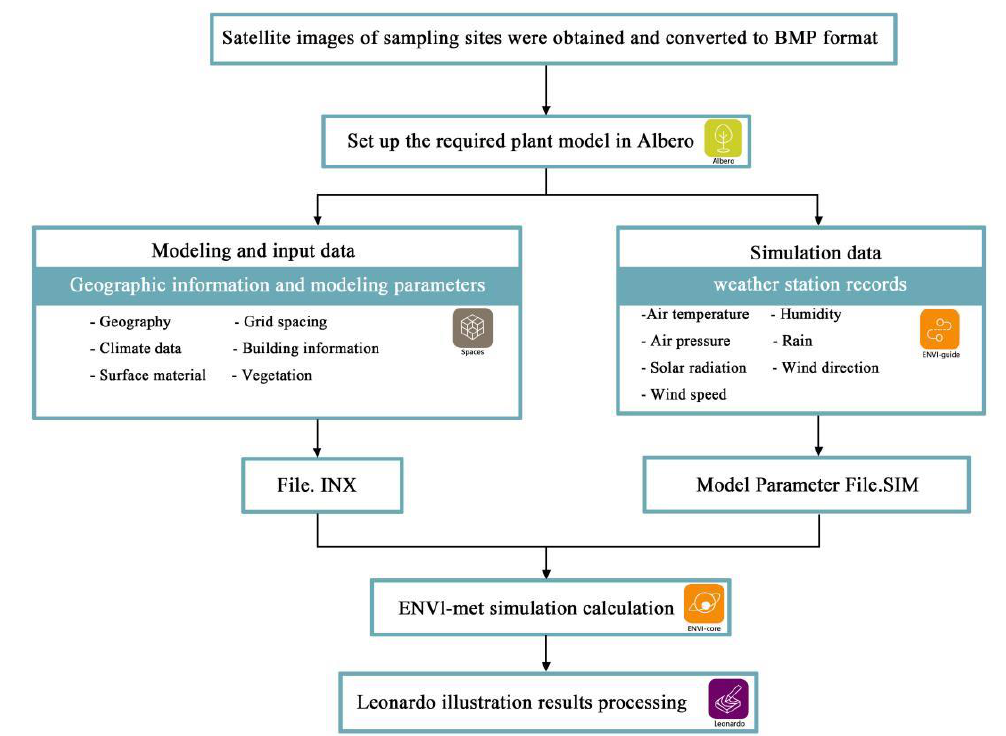
Figure 2. Sketch map of the modeling process.